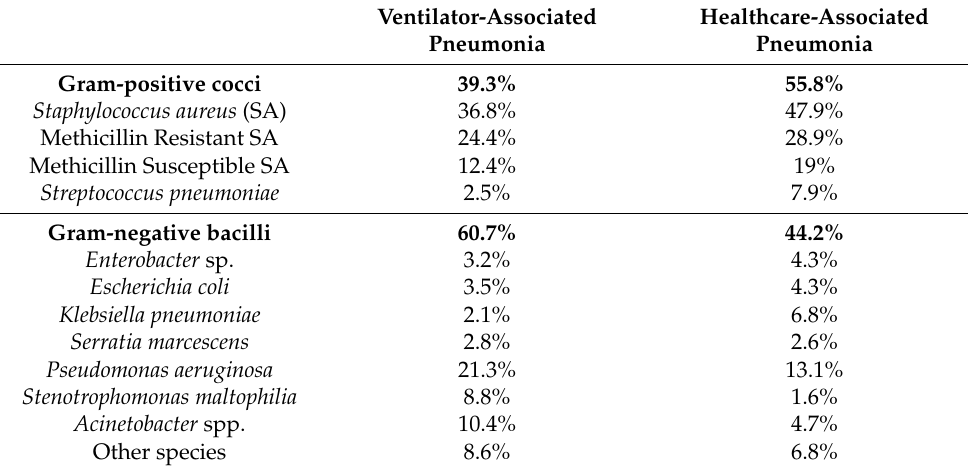
Table 1. Frequency of isolation of pathogens from patients with Ventilator-Associated Pneumonia (VAP) and non-ventilated patients with Hospital-Acquired Pneumonia (HAP) [32]. Ventilator-Associated Healthcare-Associated Pneumonia Pneumonia Gram-positive cocci 39.3% 55.8% Staphylococcus aureus (SA) 36.8% 47.9% Methicillin Resistant